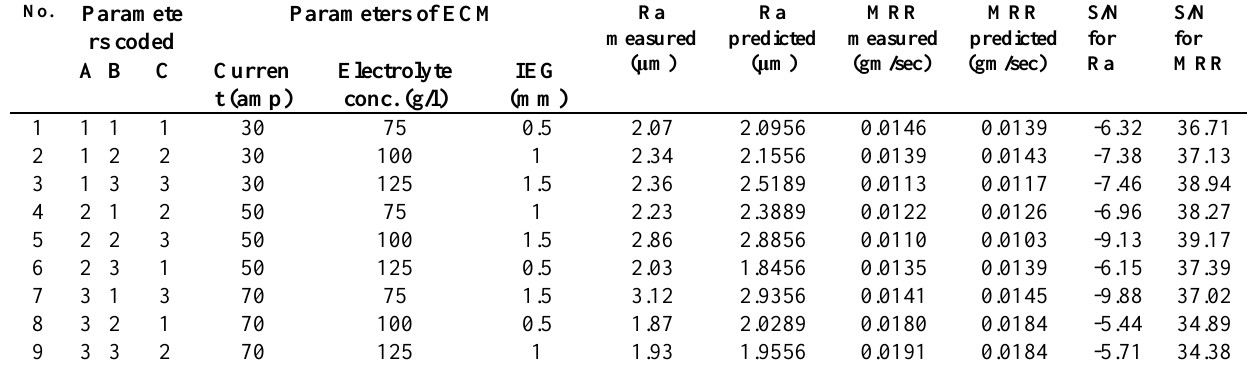
ECM Parameters According to Taguchi Method No.